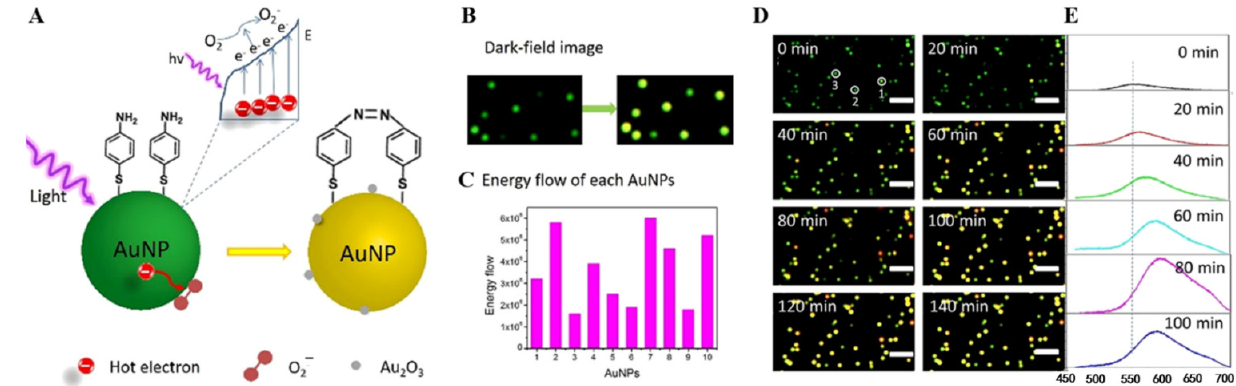
Figure 8. The energetic charge flow in the plasmon-driven photocatalytic oxidation reaction at a single NP by DFM; ( A ) Photocatalytic oxidation mechanism of p-ATP to DMAB on the surface of Au NPs, ( B ) typical DFM images before and after the photocatalytic reaction as represented in ( A , C ) flow of energetic charge in each Au NPs to the adsorbed molecules during the photocatalytic reaction. Dynamic changes of DFM imaging and scattered spectra of Au NPs during the oxidation reactions of p-ATP. ( D ) Dynamic DFM imaging of Au NPs captured at the same position every 20 min. ( E ) Spectral measurement of the same Au NP at different time points during the reaction. Reprinted with permission from [67]. Copyright 2022 American Chemical Society.